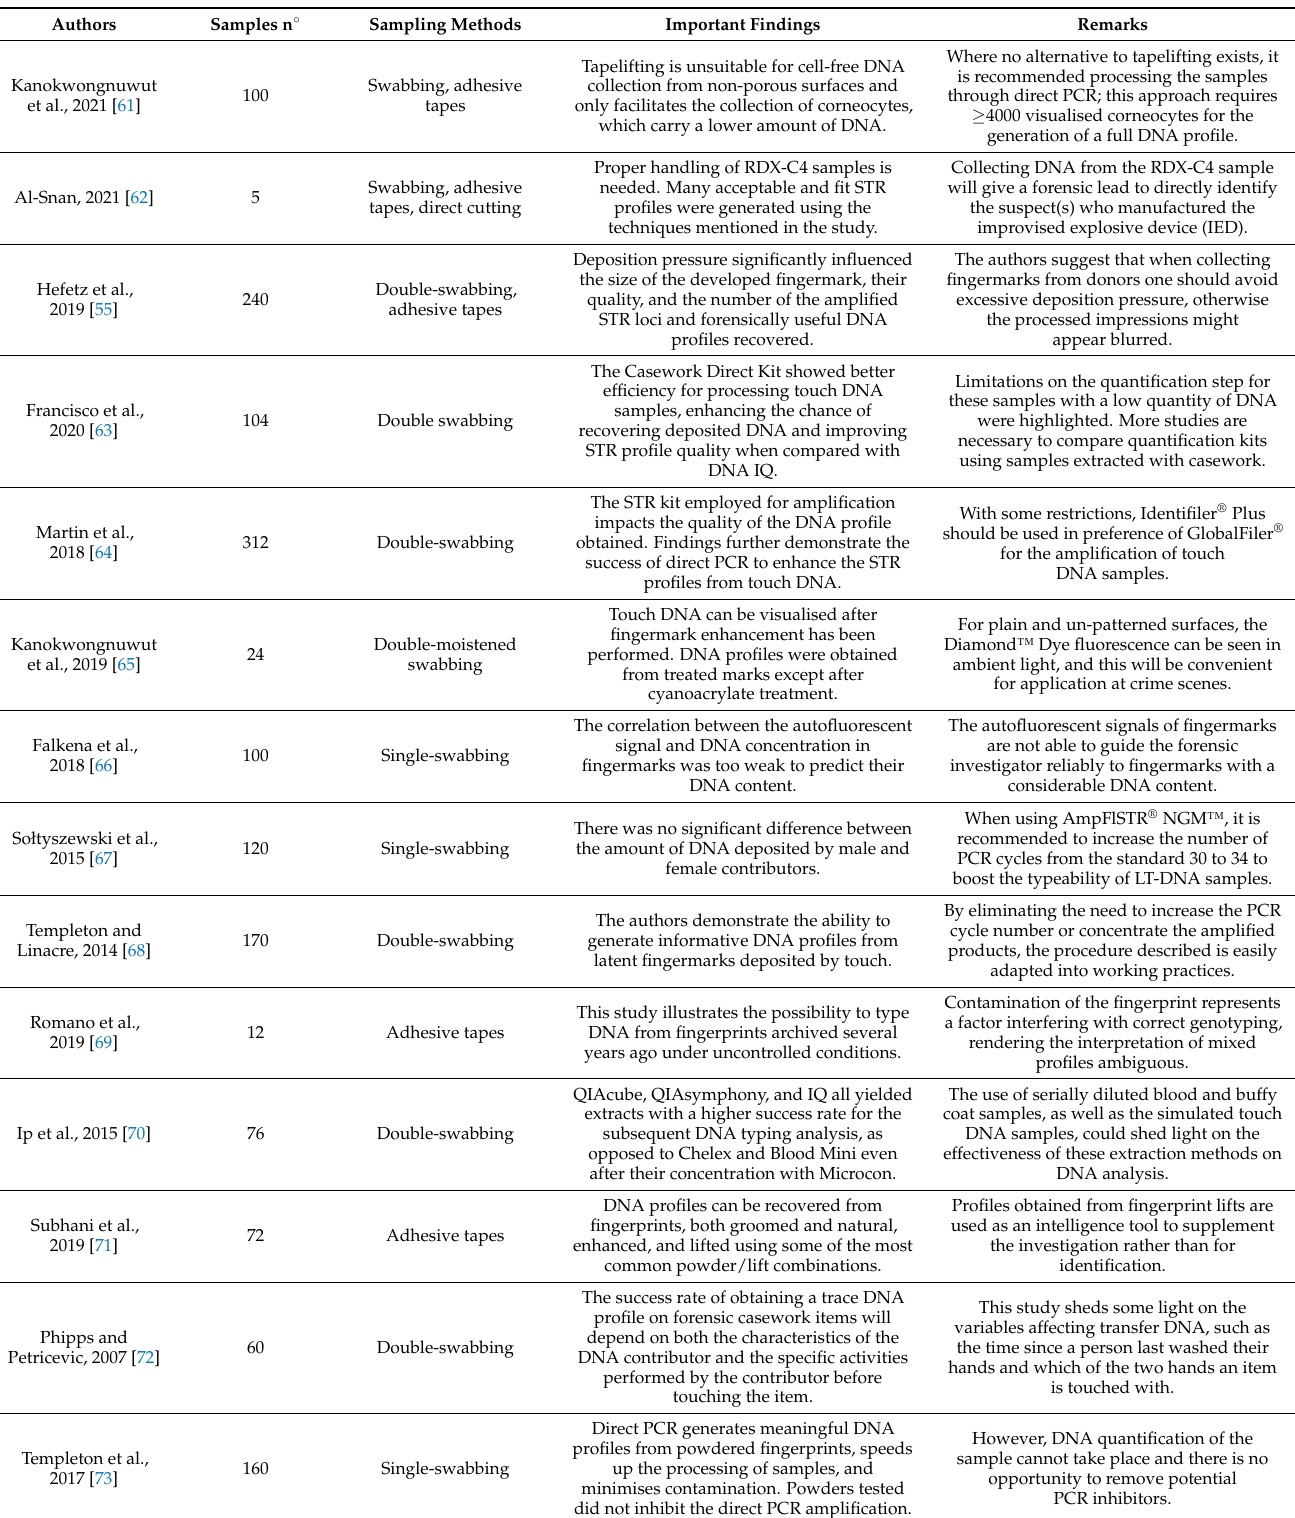
Table 2. Papers categorized in Group 2. Features displayed are authors and publication year, number (n ◦ ) of samples collected, sampling methods implemented, important findings, and remarks